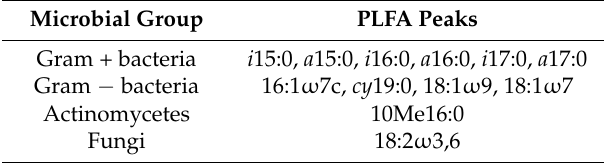
Table 1. Classification of Phospholipid Fatty Acid (PLFA) peaks as specified by [50]. Microbial